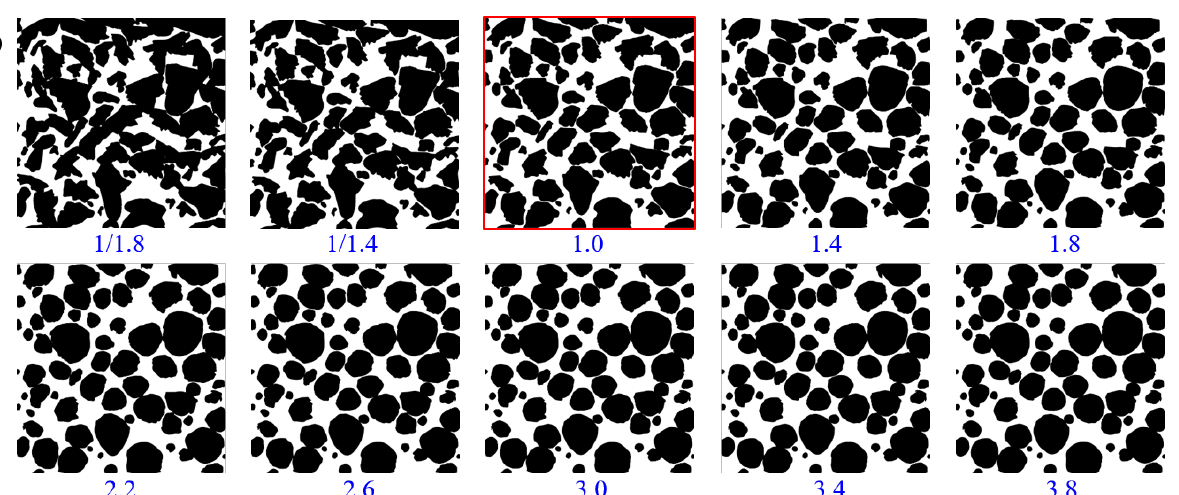
Figure 14. Influence of grain space on permeability. ( a ) Pore models with different grain spaces; ( b ) porosity and permea- bility of pore models with different grain spaces; ( c ) flow paths and velocity of pore models with different grain